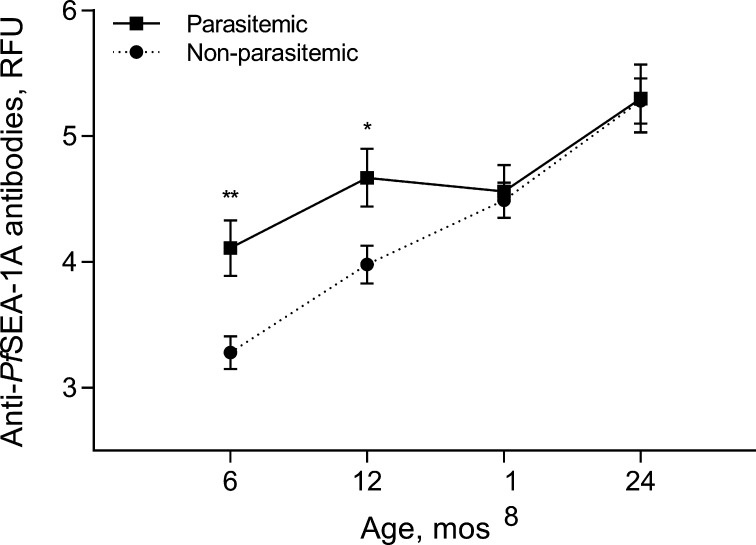
Effects of P. falciparum parasitemia experienced from birth to six months of age on anti-PfSEA-1A antibody levels. Anti-PfSEA-1A antibody levels were natural log-transformed. Error bars represent 95% confidence intervals. *P < 0.05 and **P < 0.001 compared with non-parasitemic.